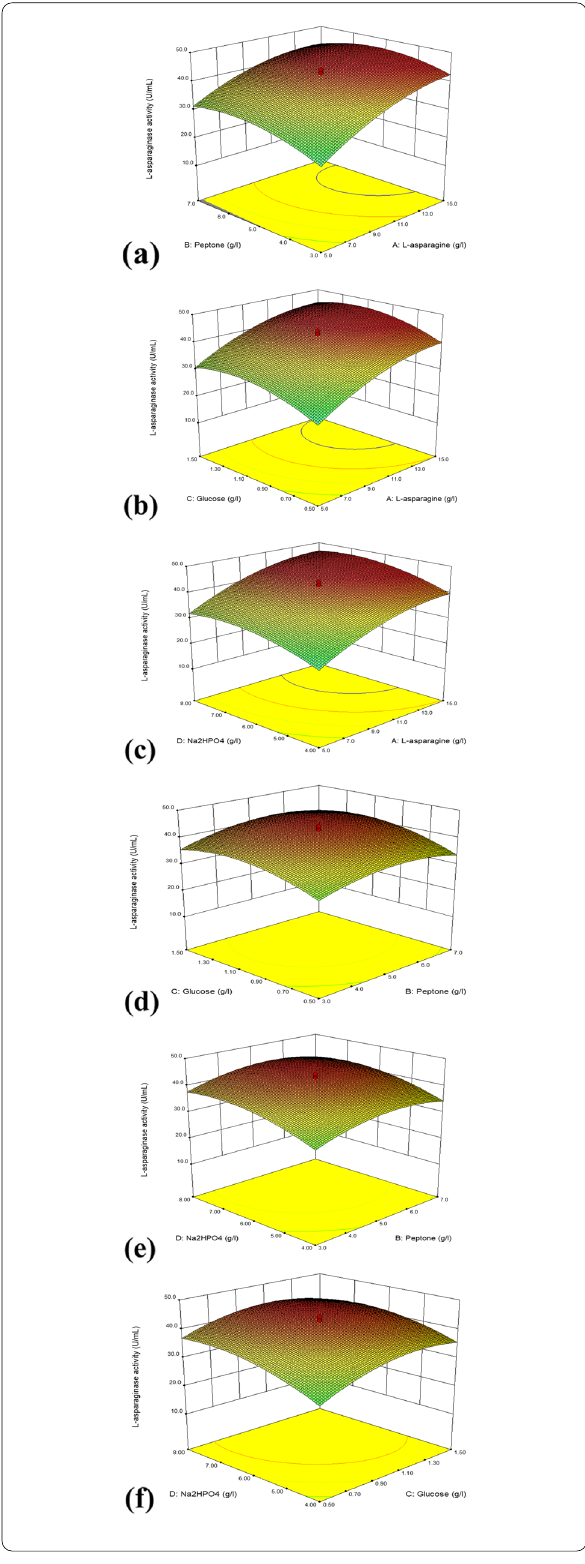
Fig 3 Response surface plot showing the interaction between variables a peptone and l -asparagine, b glucose and l -asparagine, c Na 2 HPO 4 and l -asparagine, d glucose and peptone, e peptone and Na 2 HPO 4 , and f glucose and Na 2 HPO